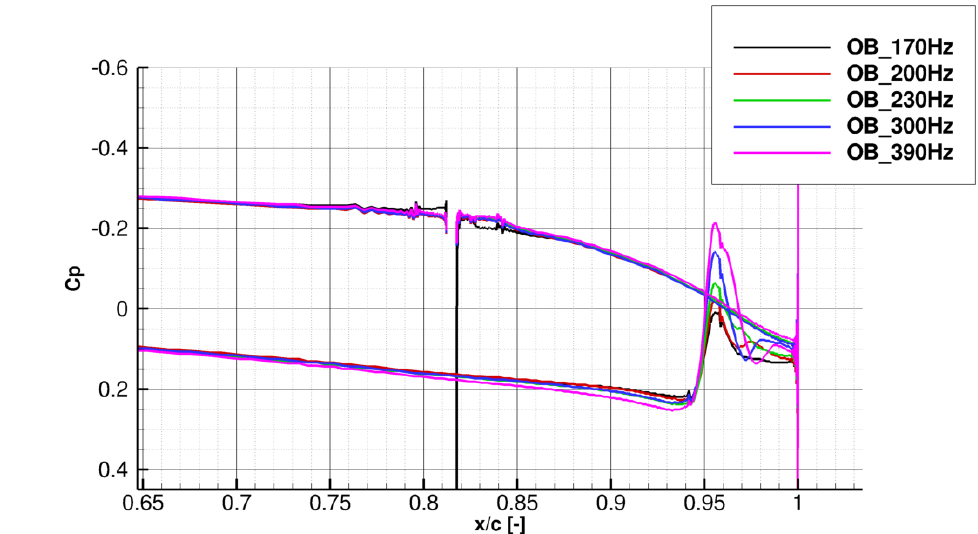
Figure 17. Detail of C p distribution at the trailing edge region. SaOB case ( top ) and oscillatory blowing ( bottom ). Oscillatory blowing for low C µ is added to the upper figure, for